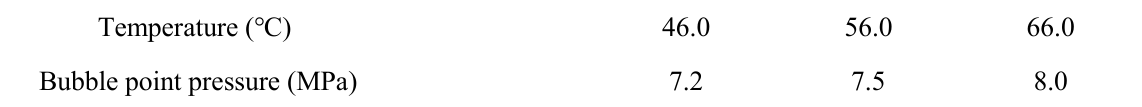
Figure 2—P-V diagram of crude oil at different temperatures. Table 2—Bubble point pressure of crude oil at different temperatures.